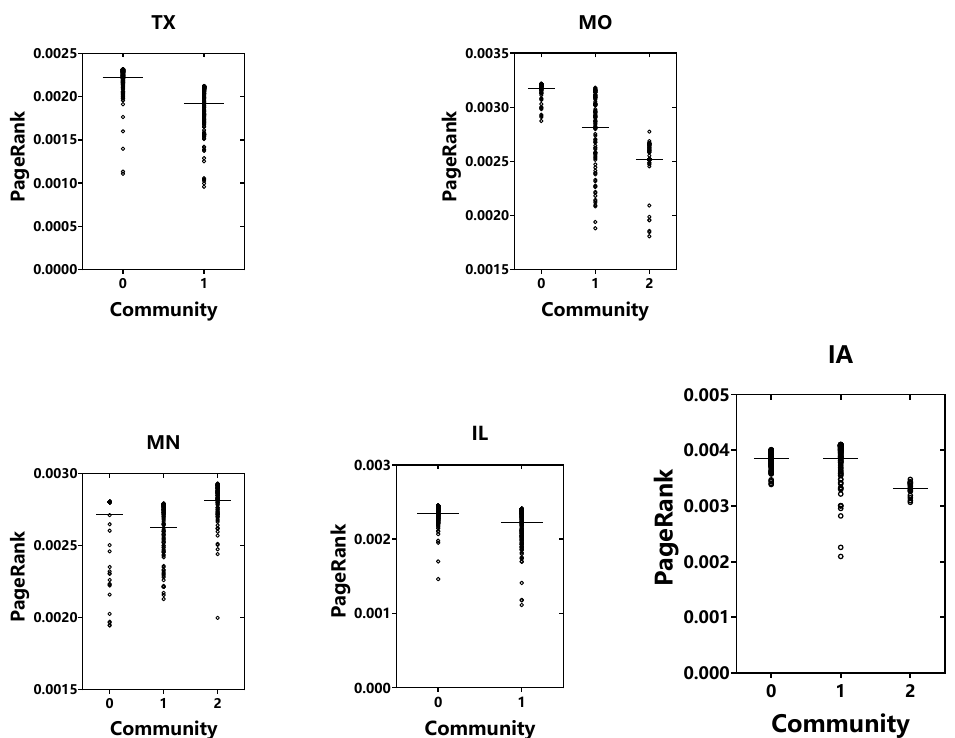
Figure 5. Scatter diagrams of PR values for communities in the five networks of TX, MO, MN, IL, and